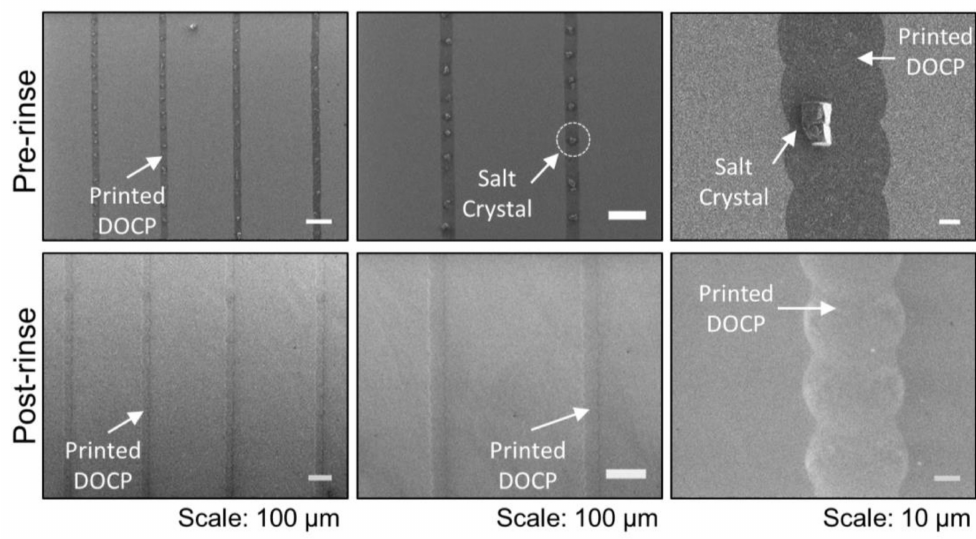
Figure 3. SEM characterization of inkjet-printed tethered phospholipid bilayers on a TiO 2 surface: top—crude printed bilayers at different magnifications with salt crystals present, which originate from the buffer, immediately after printing, and bottom—printed bilayers following water rinse to remove salt crystal